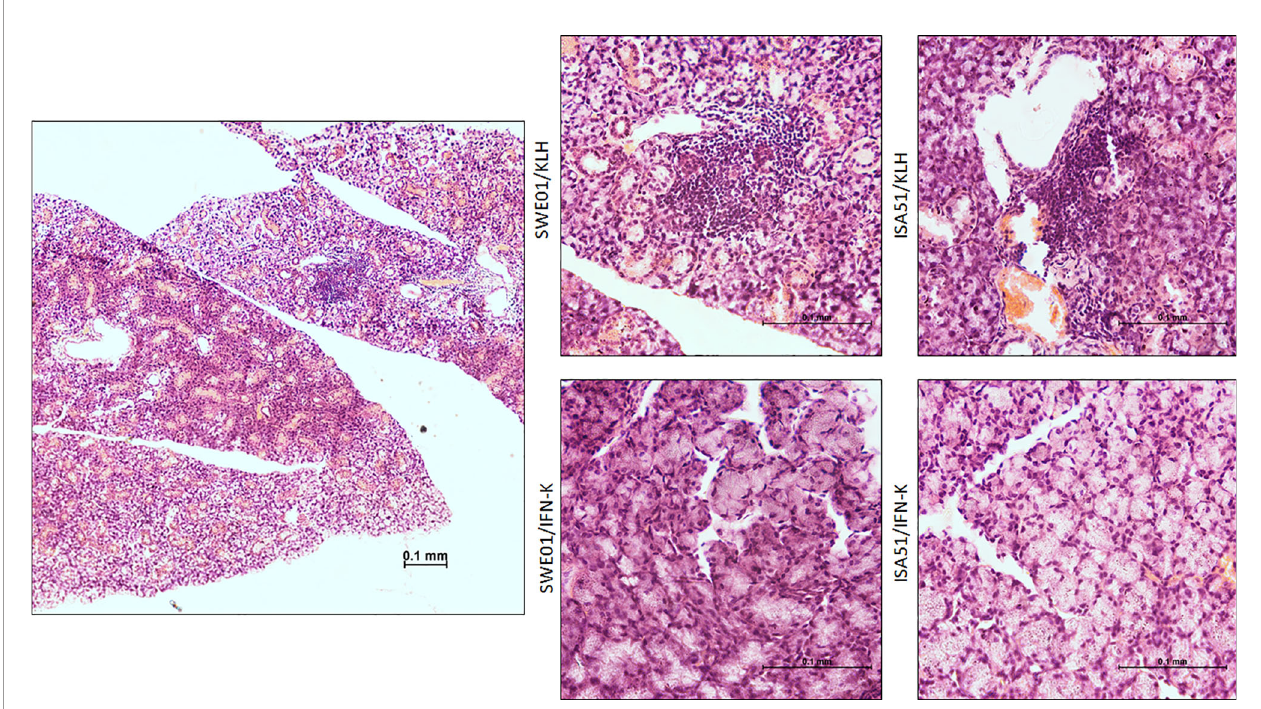
FIGURE 4 | Salivary histopathological features. Representative low (left; x10) and high (right; x40) magni fi cation images of hematoxylin and eosin-stained sections of the submandibular glands harvested at the end of follow-up in SWE01/KLH (n=5), SWE01/IFN-K (n=6), ISA51/KLH (n=7) and ISA51/IFN-K (n=7) living mice, are